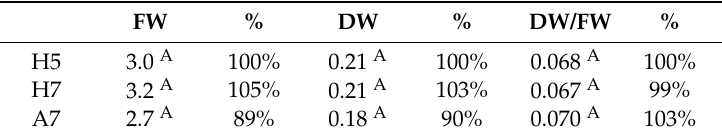
Table 8. Rootball mean response 1 to the treatments for fresh weight (FW, g), dry weight (DW, g), and dry weight to fresh weight ratio (DW/FW, g/g or dimensionless). Differing letters within response variables (columns) denote significance at alpha = 0.05.